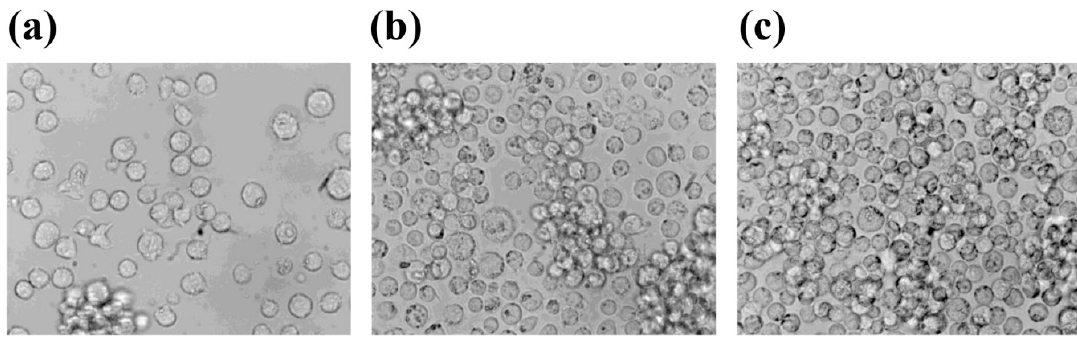
Figure 6. Bright field images of Jurkat cells. he images were acquired using a Leika DMIR microscope with a 40 × objective, and show cells soon after cell seeding ( a ) or after 96 h at 1 × g ( b ) or at RPM ( c